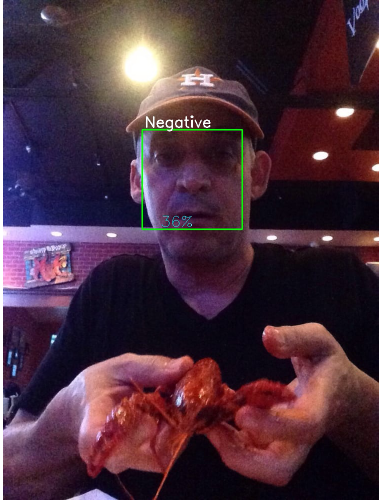
Fig.11. Image identified as a negative